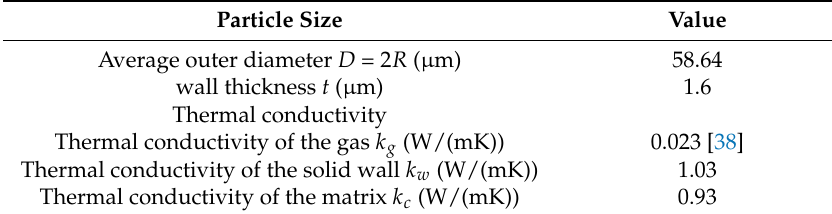
Table 2. Geometrical and physical properties of HGM for simulation.